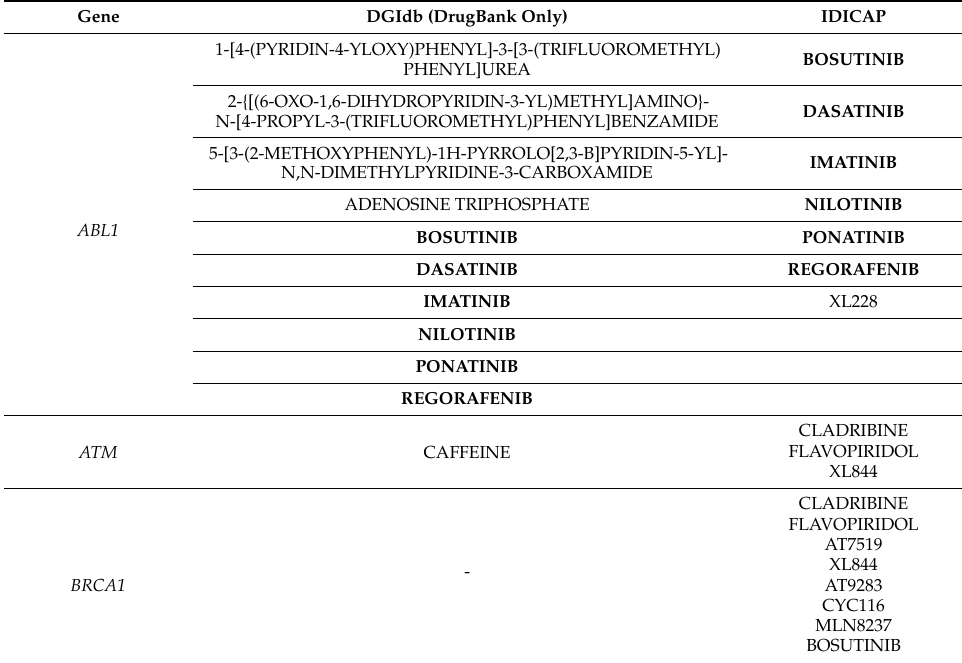
Table 2. Comparison of search results between DGIdb and IDICAP. Common results shared between the two tools are highlighted in